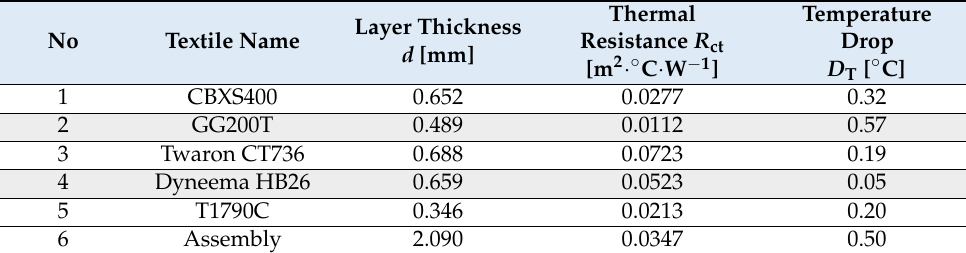
Table 4. Comparison textile thickness and simulated temperature drop.